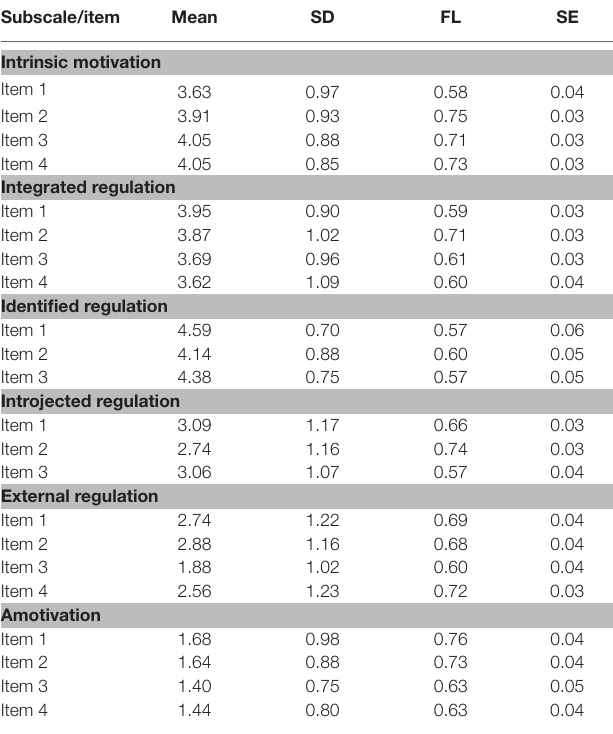
TABLE 1 | Descriptive statistics, standardized factor loading, and standard error of the Chinese